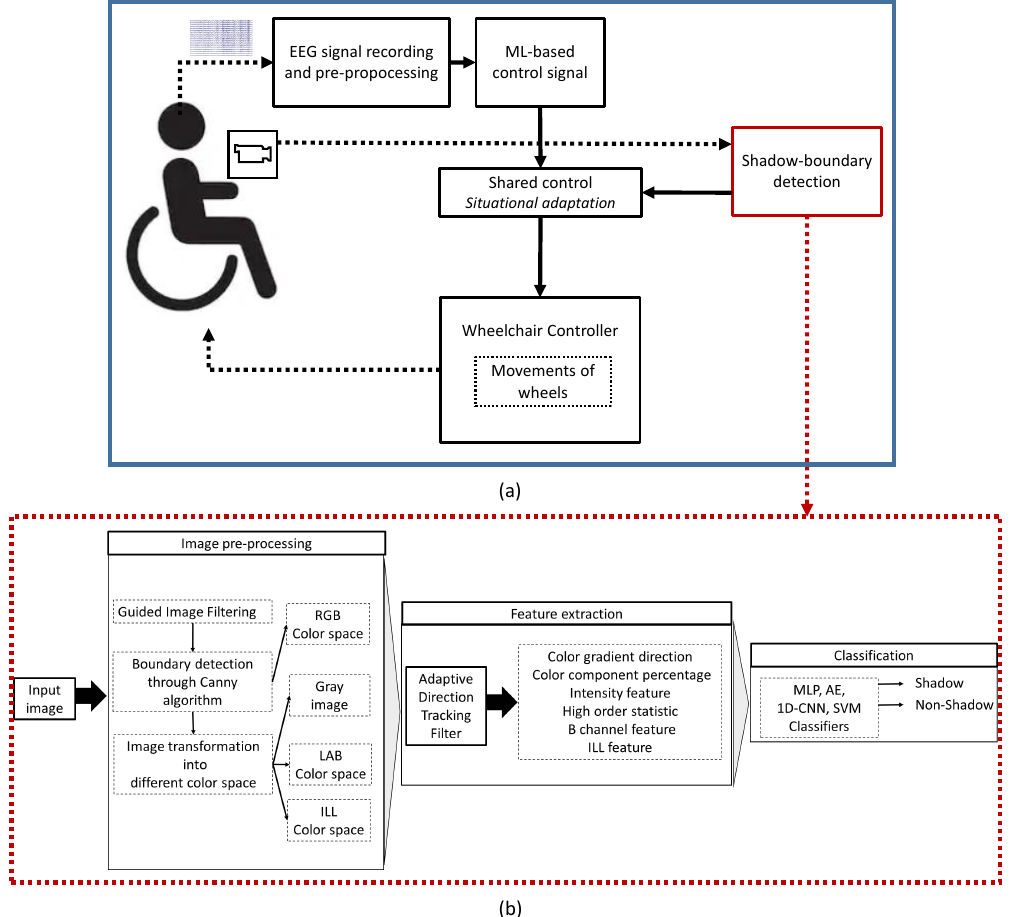
Figure 1. ( a ) BMI block diagram for wheelchair control. ( b ) Proposed shadow boundary detection